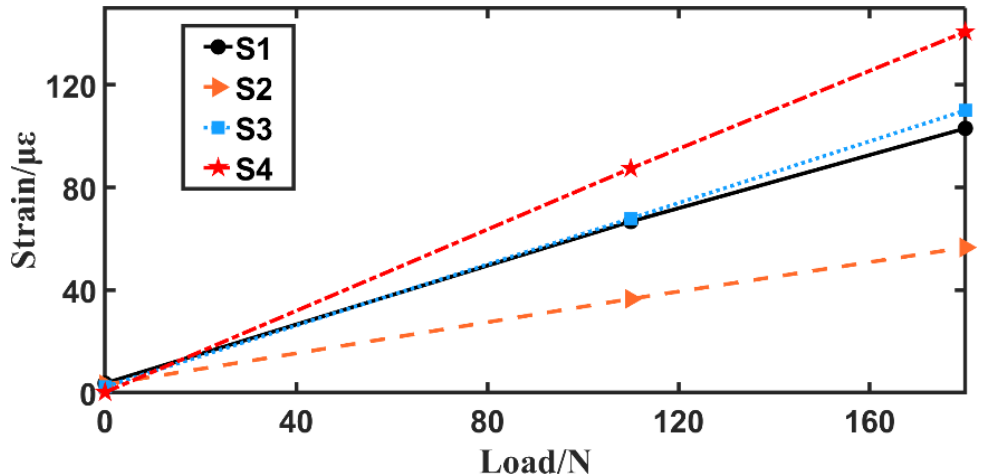
Figure 7. The static load–strain relationship of double pylon.